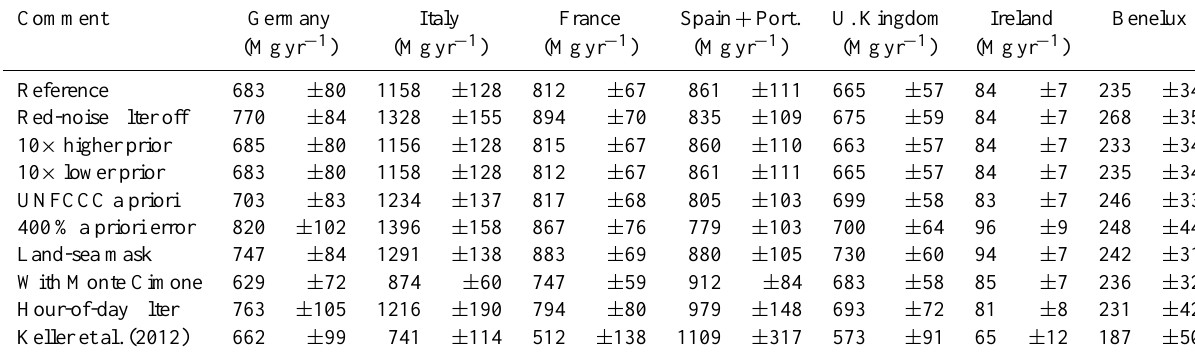
Table 6. Sensitivity of country-specific HFC-125 emissions in 2009 to different inversion